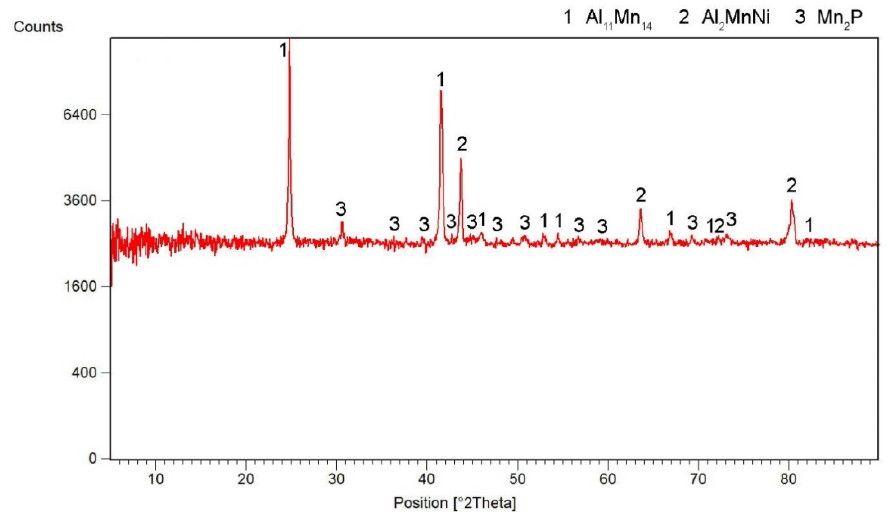
Figure 1. X-ray diffraction pattern of a metal sample in the reduced state.